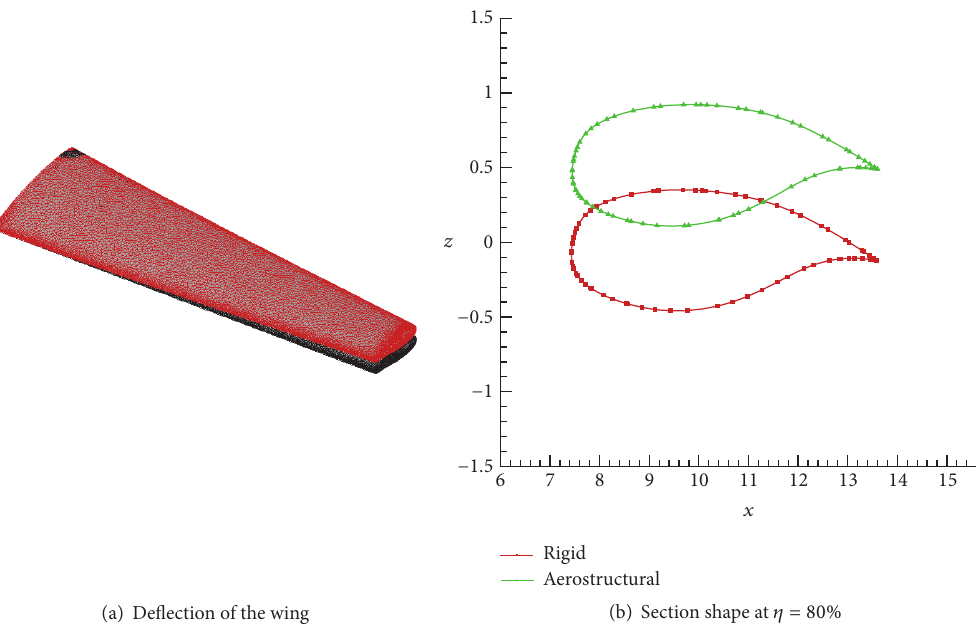
Figure 13: Effect of static aeroelasticity.